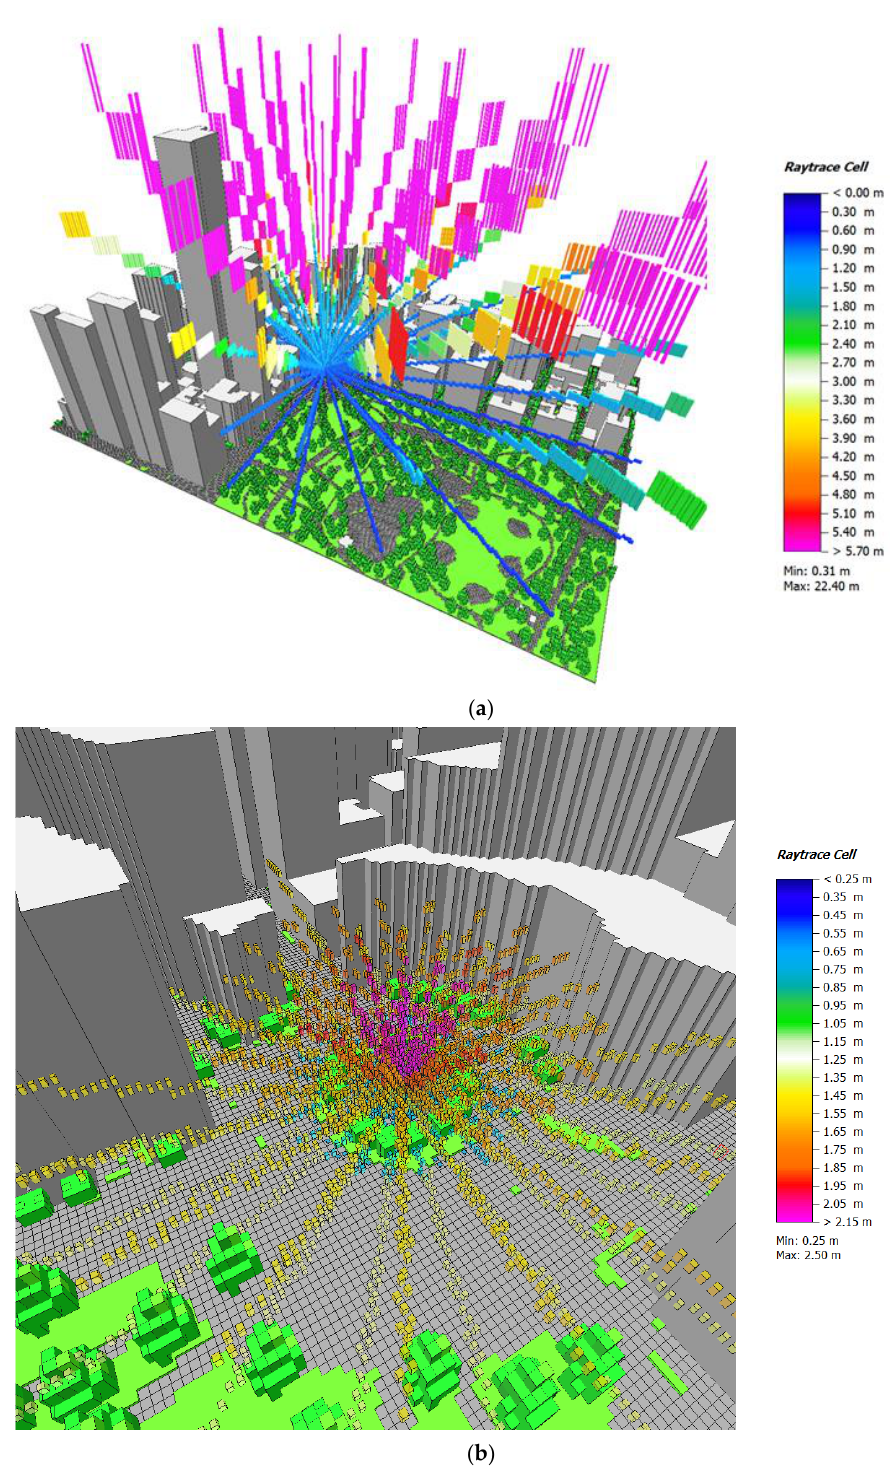
Figure 4. This specifically generated simulation output depicts the length of raytracing segments for one observed grid cell above the center of Columbus Circle. The 3D output view shows these raytracing lengths from a far perspective demonstrating the long ray distance and the length increase with height in ( a ) and from a nearby perspective with a 50 % decreased data cube size, 50 % data cube transparency, and data being filtered for height levels below k = 13 to visualize the high view sphere resolution and the resulting rays near the observed cell in ( b ).